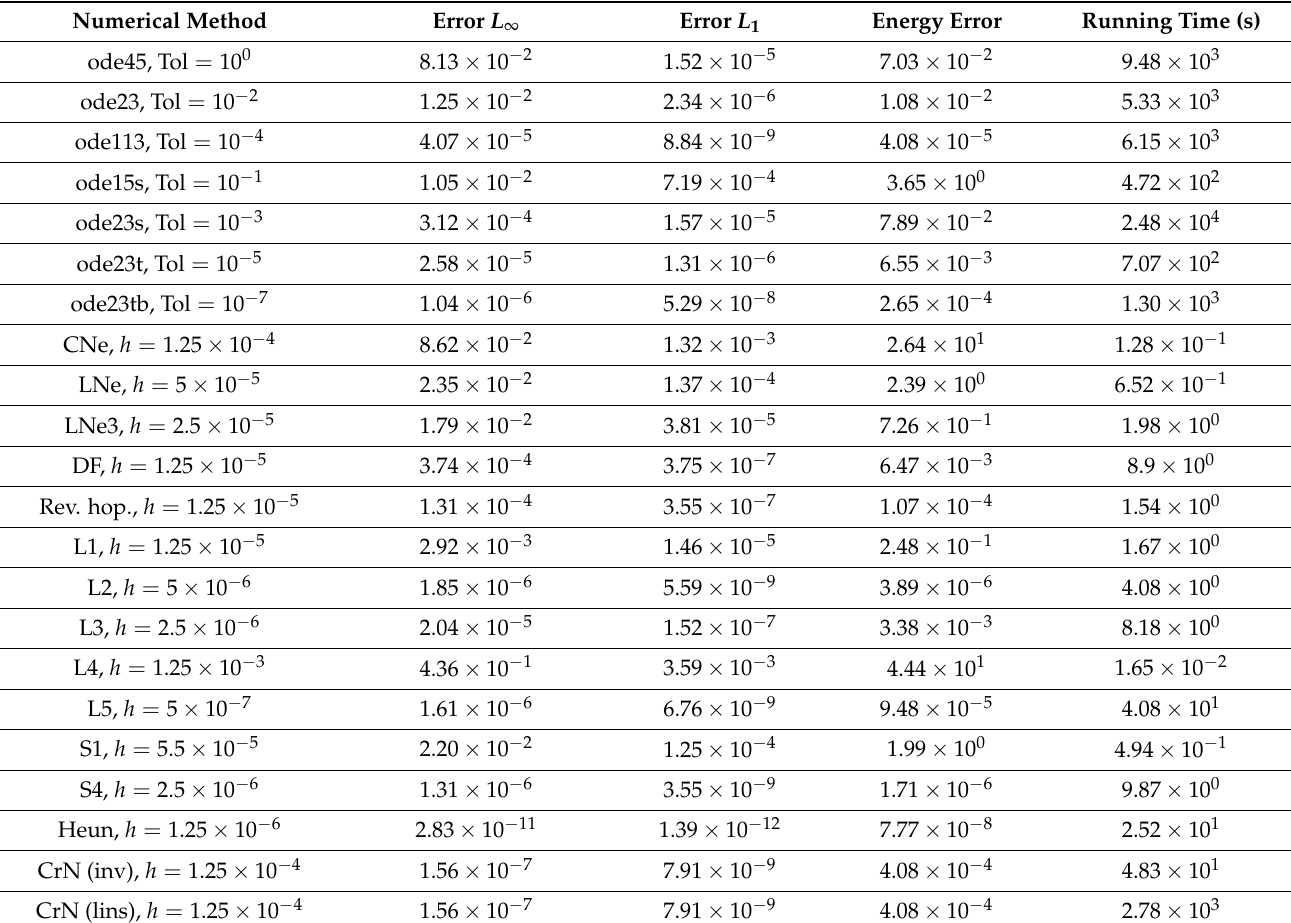
Table 2. Comparison of different algorithms for the very stiff system of ten thousand cells.